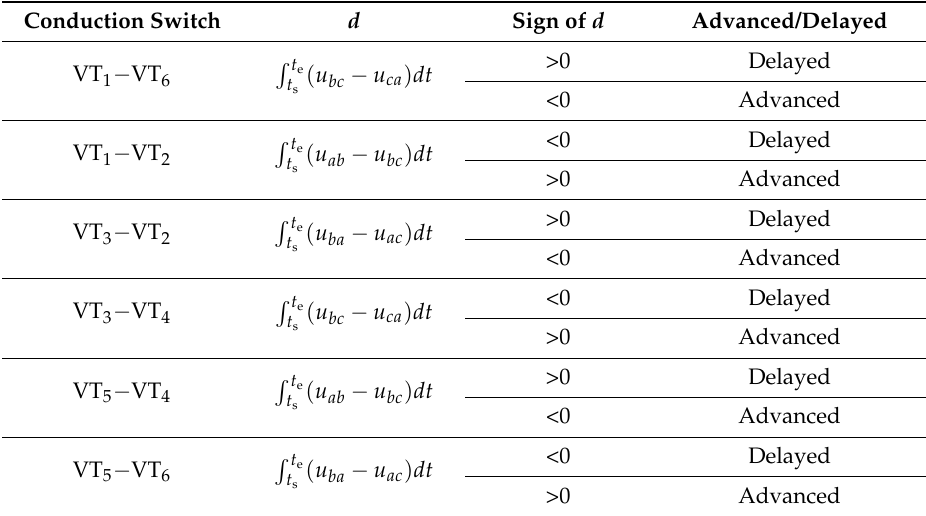
Table 1. Relationship between the integral d , conduction switch, and commutation error.